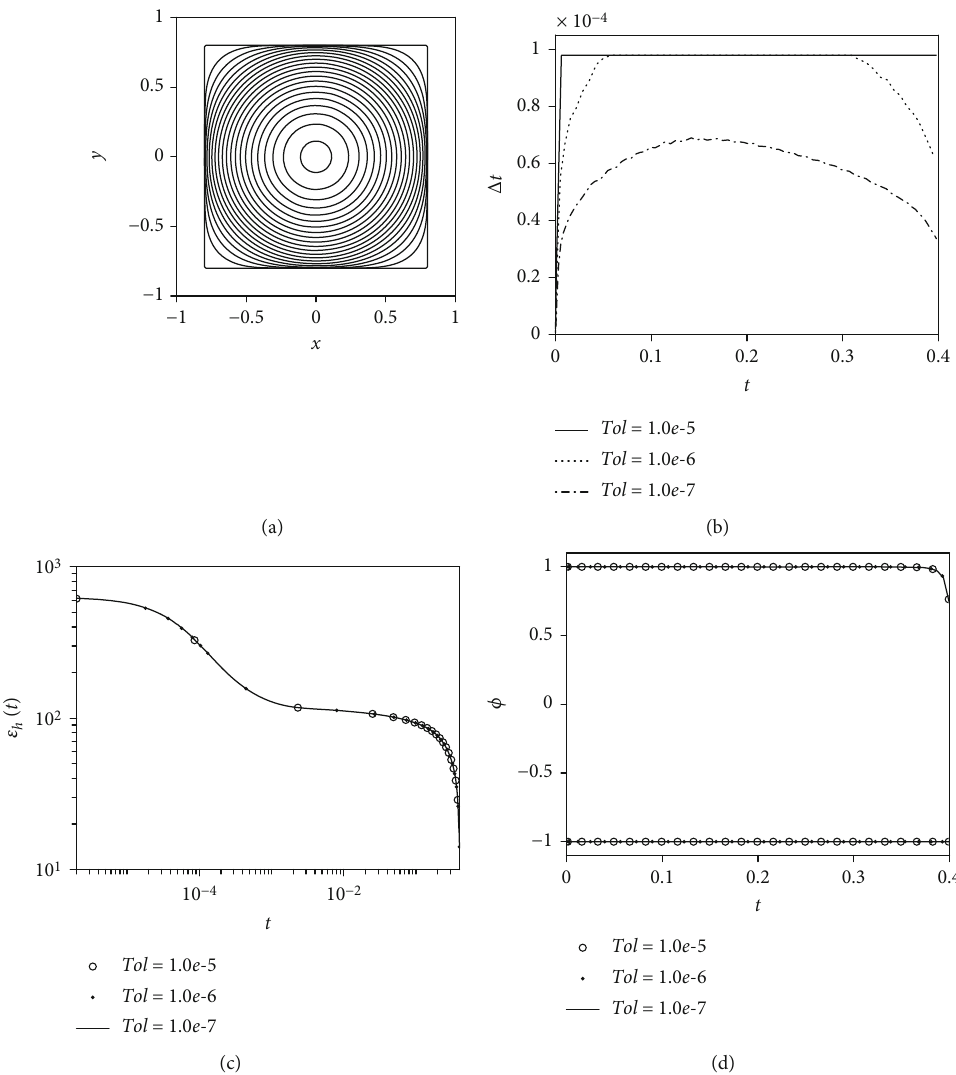
Figure 6: Temporal evolution with the initial states (14): (a) zero level contour of ϕ ð x , y , t Þ with tol = 1 : 0 e - 7 and (b – d) the changes in the time step size Δ t , the discrete total energy E h ð t Þ with di ff erent tol values, and the maximum and the minimum of ϕ